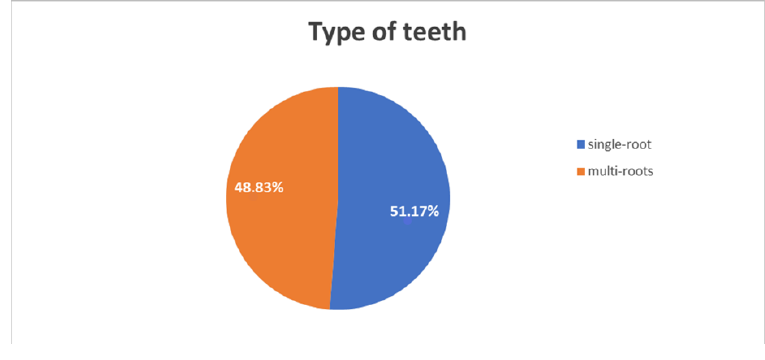
Figure 2. Type of teeth.